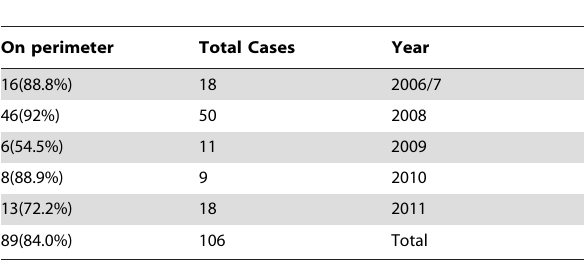
Table 1. The yearly distribution of CL cases from Sde Eliyahu.